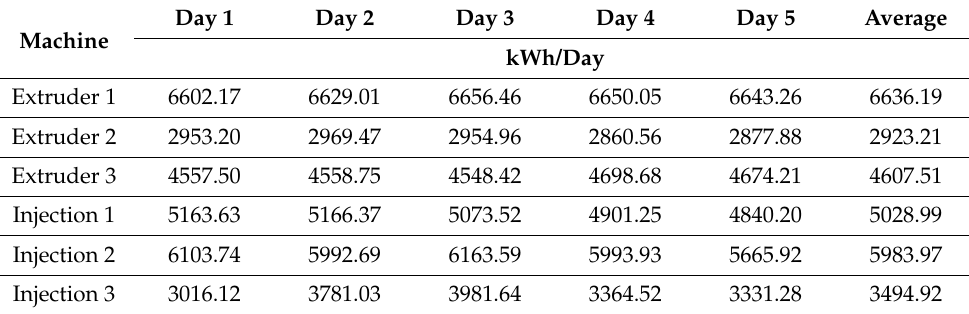
Table 7. Electricity consumption from different